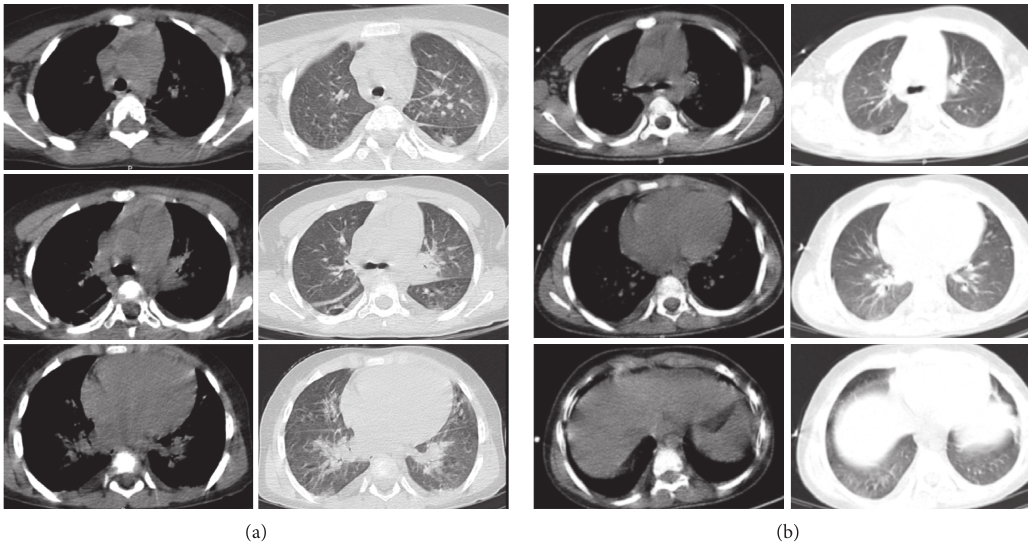
Figure 1: (a) The computed tomography (CT) scan depicts increasing vascular marking, interlobular septal thickening, ground-glass opacities, and mild bilateral pleural effusion. (b) A second computed tomography of the patient is shown here. There is no evidence of pleural effusion or pleural thickening, and the ground-glass opacities got almost clear.